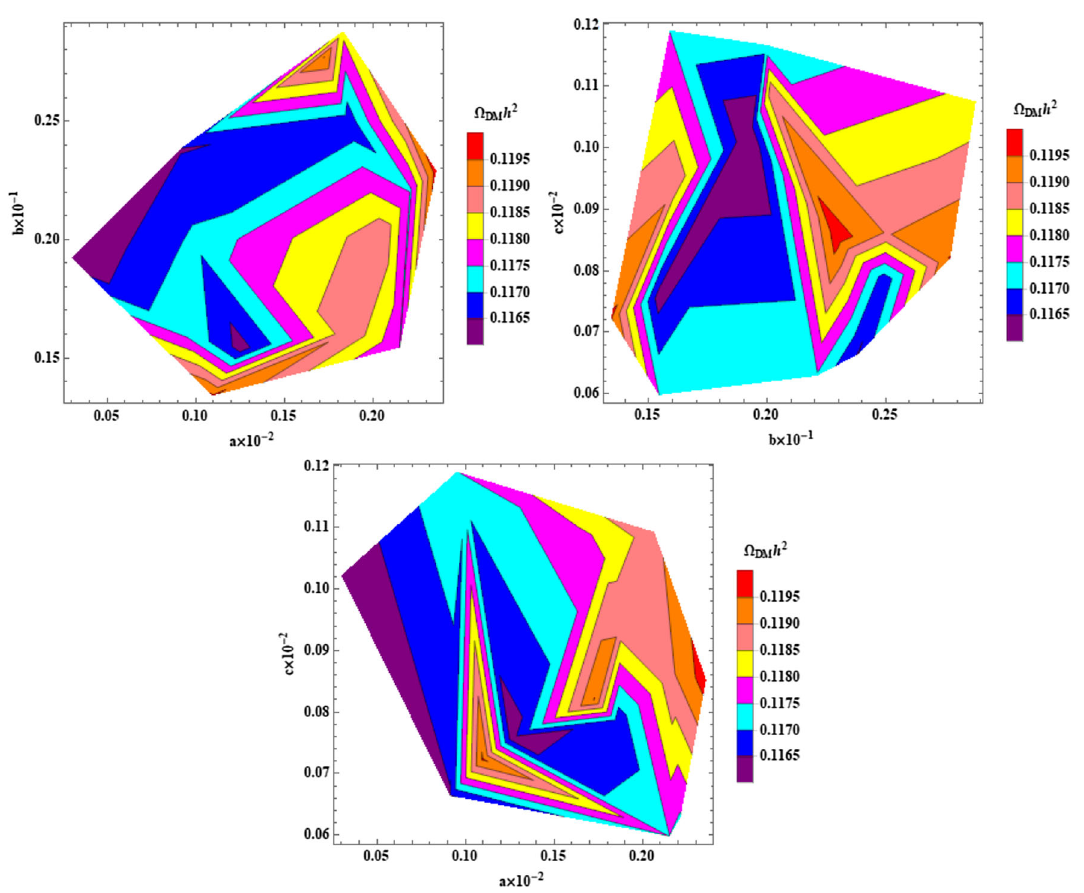
Fig. 14 Contour plot relating the Dirac masses a and b w.r.t the relic abundance ( (cid:20) DM h 2 ) of the DM candidate ( ξ ) (left panel), right panel shows variation of b and c with (cid:20) DM h 2 and in the middle we show a